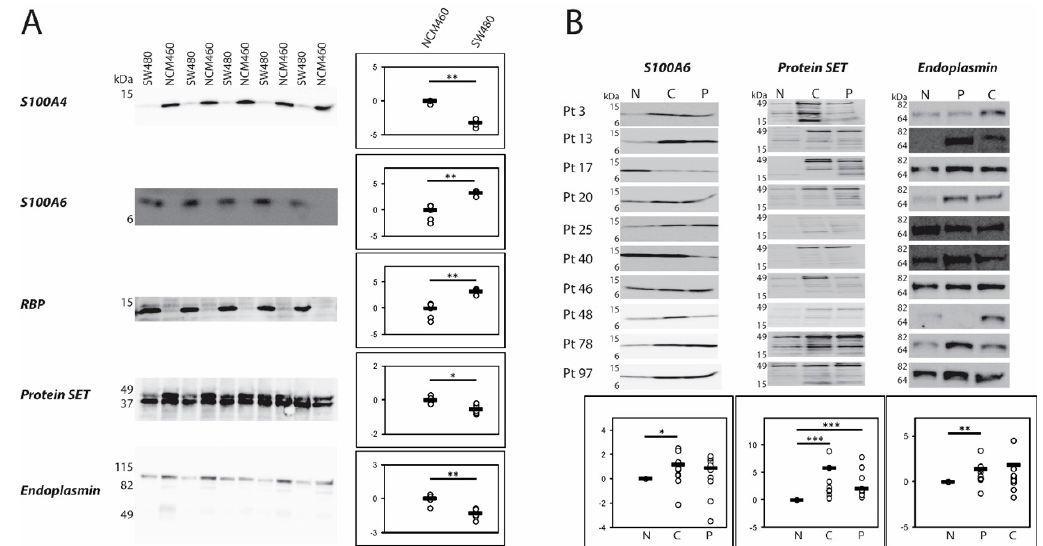
Figure 4. Western blotting of potential markers. ( A ) NCM460 and SW480 cells were grown in separate rounds and harvest prior to total protein concentration determination and equal amount of protein were loaded on the gels. Pixel intensity was measured in each band and the mean value of NCM460 was used as reference set to 1. Total pixel intensity from the two bands for protein SET showed no significant di ff erence ( p = 0.2). However, quantifying the top band alone showed significant up-regulation in NCM460 ( p < 0.05) whereas the lower band showed no significant di ff erence ( p = 0.9). p values were calculated with Mann-Whitney U-test. Relative pixel intensities are depicted at a log 2 -transformed scale in the dot plots. ( B ) CRC patient tissue was exercised from CRC during resection for CRC. Proteins were solubilized by homogenization in lysis bu ff er prior to total protein concentration determination and equal amounts of protein were loaded on the gels. Pixel intensity was measured in each band and the value of each non-involved (N) band was set to 1 and the periphery (P) and central (C) samples were calculated relative to the non-involved value in each patient. p values were calculated with Wilcoxon signed-rank test. Quantification of protein SET was done on the total expression (all bands together), the top band alone and the band just below the top band alone which all showed the p -values as stated in the figure. To save space, the western blot of protein SET has been compressed in the y-direction as inferred by the range of the molecular masses stated by the marker. Few bands were recognized by the endoplasmin antibody migrating approximately at 40 and 25 kDa (not shown). Relative pixel intensities are depicted at a log 2 -transformed scale in the dot plots. * p < 0.05; ** p < 0.01; *** p <